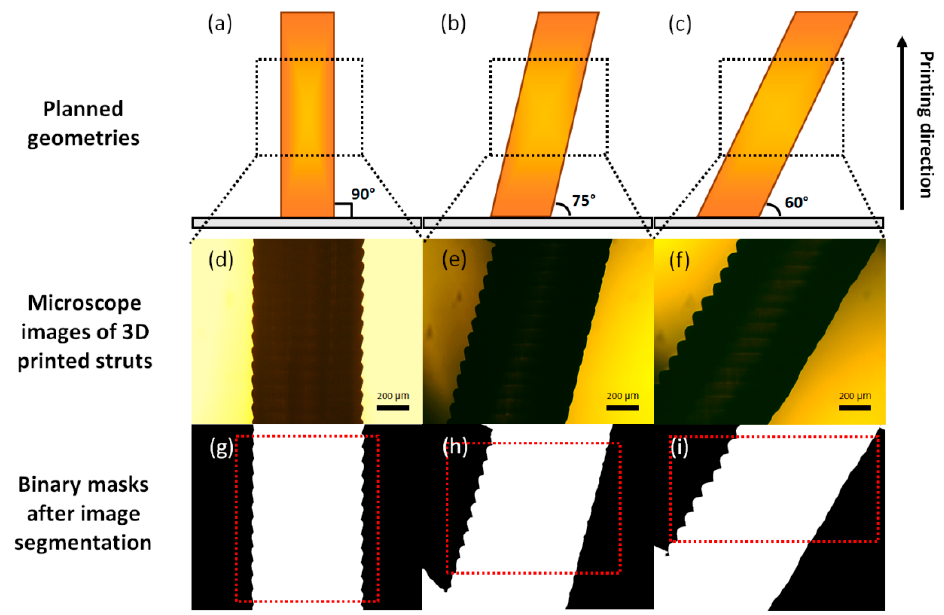
Figure 4. Microscope images and corresponding binary images of additively manufactured struts: ( a – c ) CAD geometries of struts in different printing angles (90 ◦ , 75 ◦ , and 60 ◦ ); ( d – f ) Microscope images of additively manufactured struts (90 ◦ , 75 ◦ , and 60 ◦ ); ( g – i ) Binary masks after image segmentation (90 ◦ , 75 ◦ , and 60 ◦ ). The sidewall profiles in the red box (dotted line) are used for characterizing the spatial uncertainty.